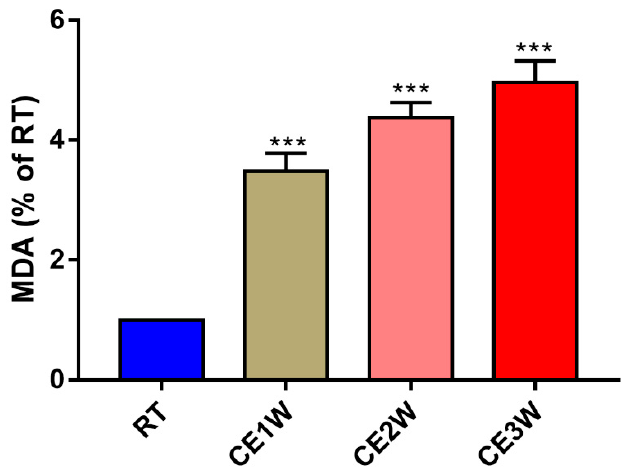
Figure 1. The malondialdehyde (MDA) level in hippocampal lysates of the chronic cold-stressed mice were measured. Data were between room temperature male (RTM) vs. cold exposure for 1 week (CE1W), CE2W and CE3W groups and were analyzed by one-way analysis of variance. The results are expressed as the mean ± SD ( n = 6) of four independent groups; *** p < 0.001.